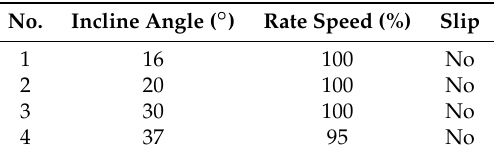
Table 3. Testing results of gradeability.